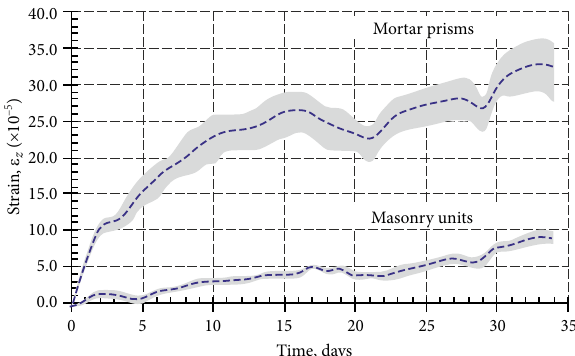
Fig. 6. The shrinkage of masonry units and mortar prisms (mortar specimens)